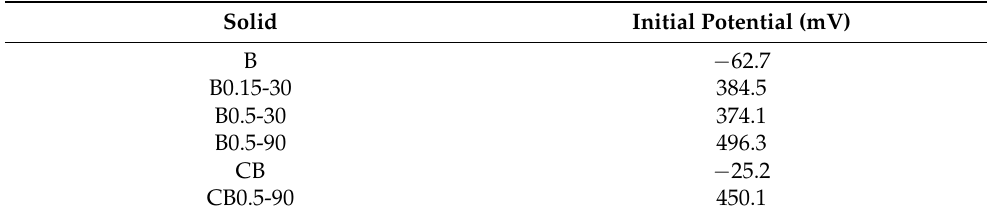
Figure 6. Potentiometric titration of the solids: ( a ) natural and activated bentonites; ( b ) silica-resin- bentonite nanocomposite. Table 4. Initial potential of the